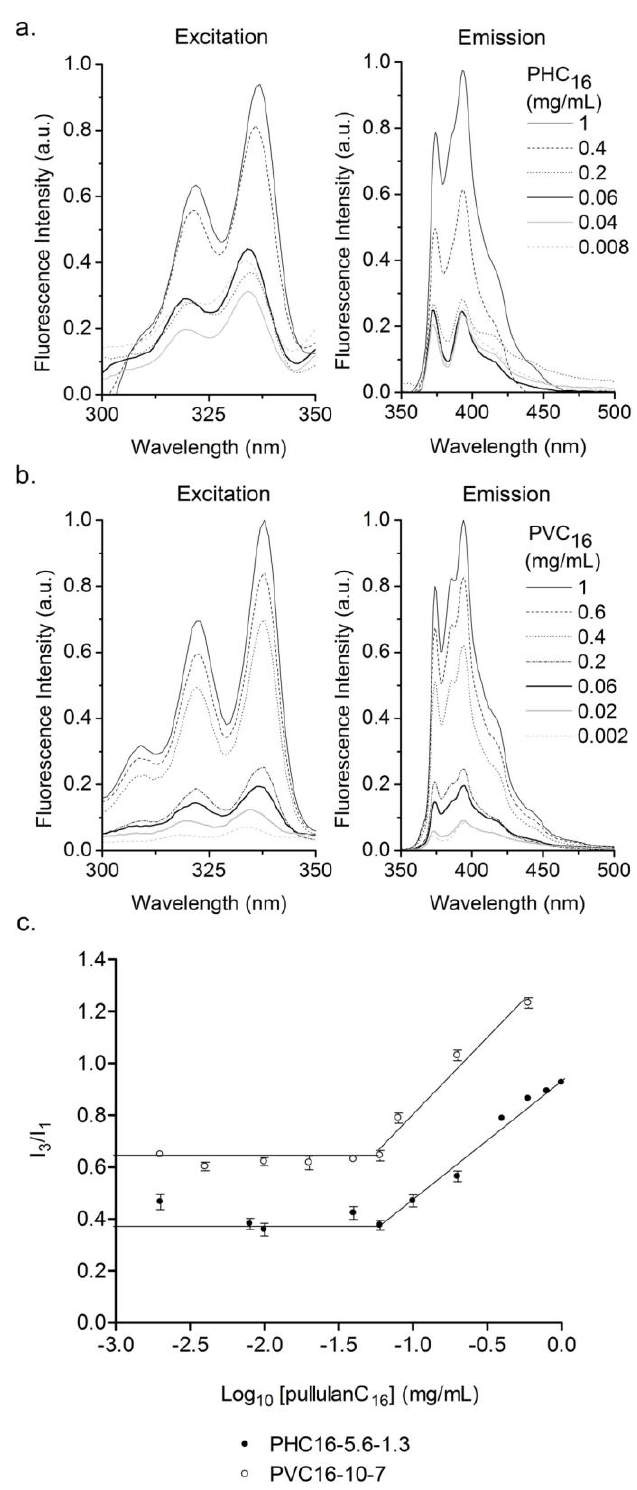
Figure 2. Determination of the critical aggregation concentration (cac) of pullulan-C fluorescence excitation (λ = 390 nm) and emission (λ em (6 × 10 −7 M) in the pullulan-C /water system as a function of the ( a ) PHC 16 ( b ) PVC -10-7 concentration; ( c ) Intensity ratio I 16 concentration. The cac obtained for both materials was 0.06